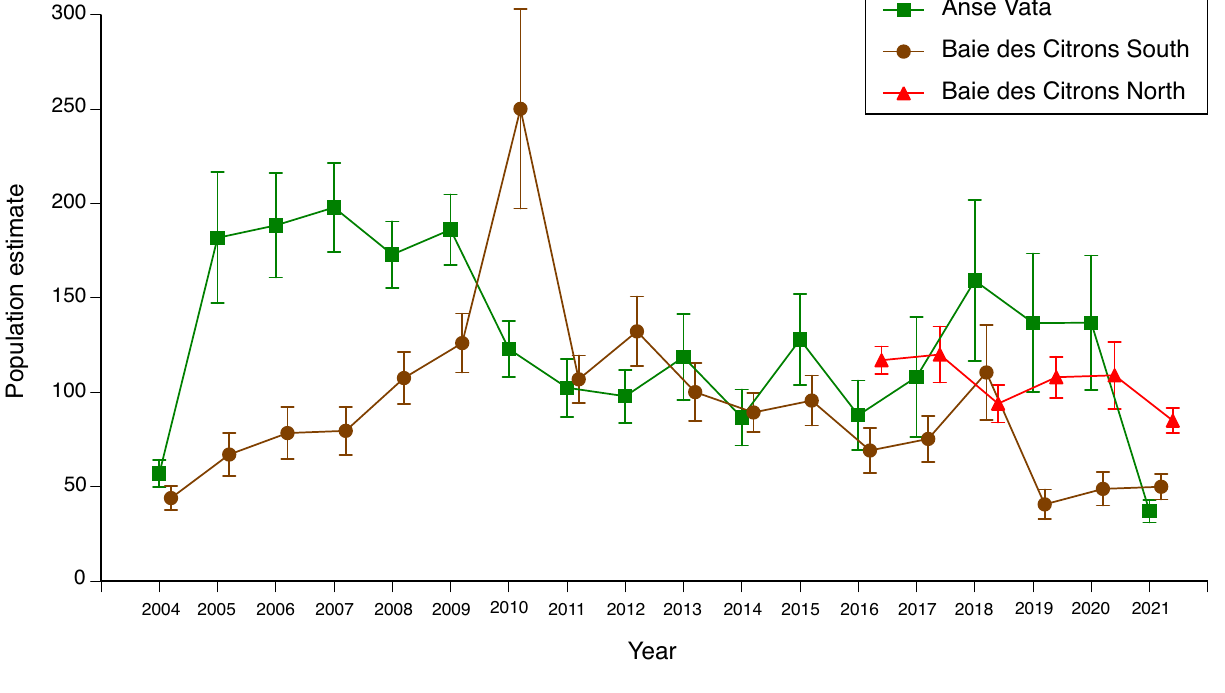
Figure 1. Jolly–Seber estimates of annual population sizes of turtle-headed sea snakes ( Emydocephalus annulatus ) in three study sites near Noumea. Estimates for each year are shown with associated standard errors.